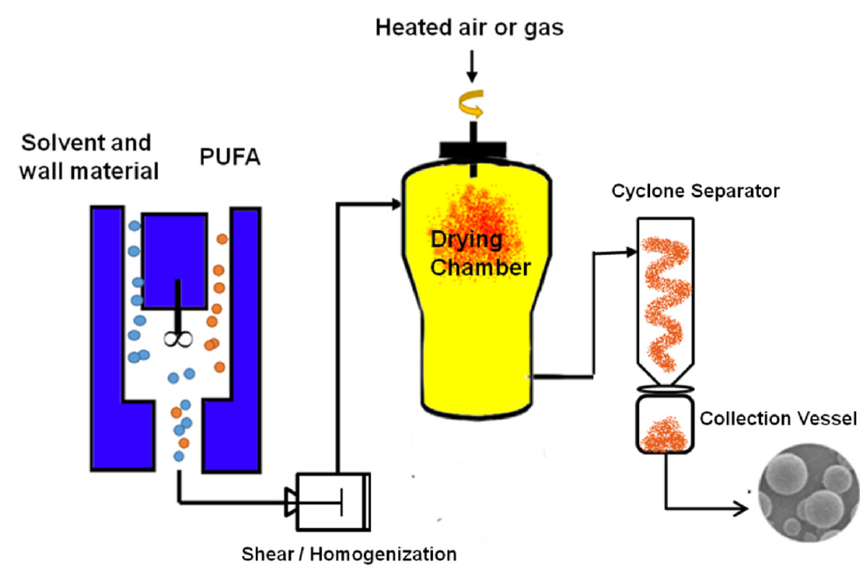
Figure 2. The process of spray drying.